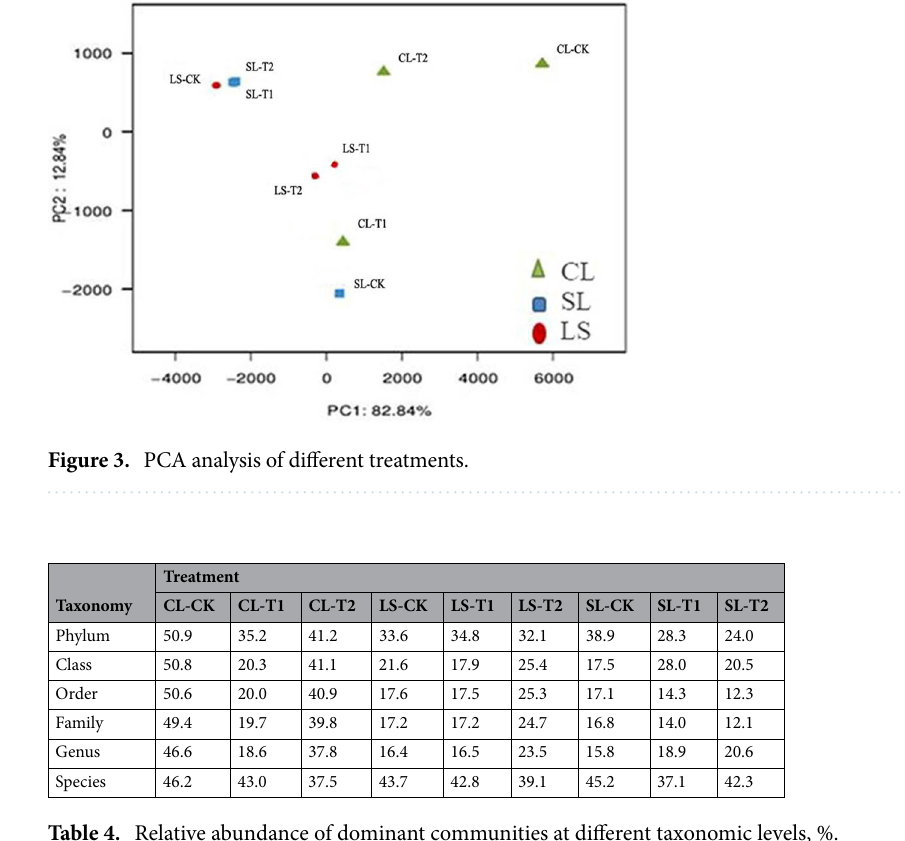
Table 4. Relative abundance of dominant communities at different taxonomic levels,